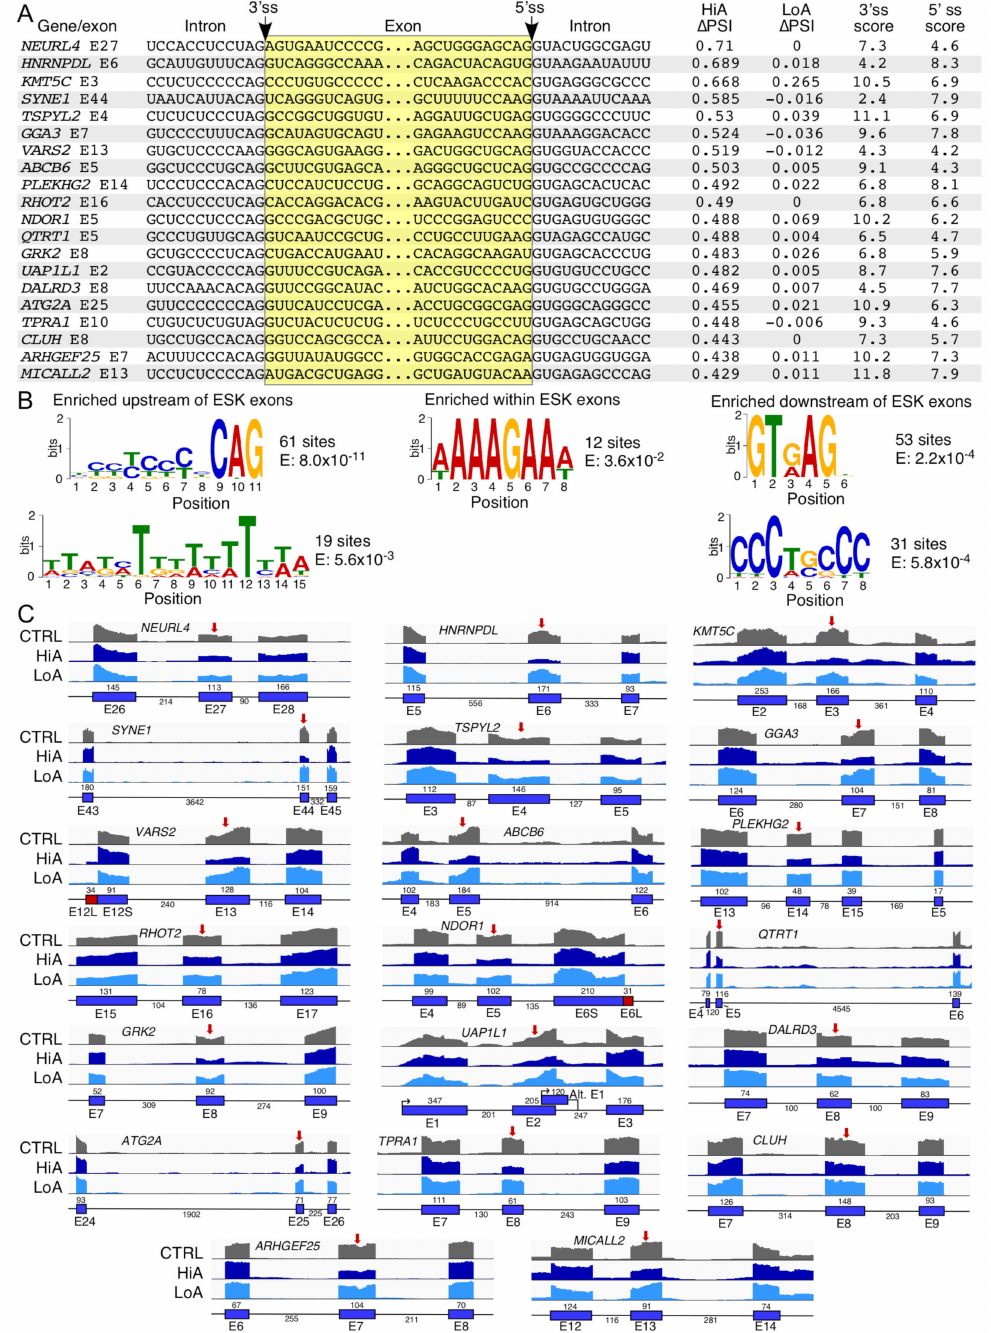
Figure 4. Increased exon skipping caused by Anti-N1 treatment. ( A ). The sequence context of 20 candidate exons exhibiting greatly increased skipping upon Anti-N1 treatment. Table contents and annotation are the same as in Figure 3A. ( B ). Enriched sequence motifs identified by MEME. Left panels: the two most enriched motifs within 50 nucleotides upstream of the 3 (cid:48) ss of affected exons, both corresponding to the polypyrimidine tract and 3 (cid:48) ss sequence. Middle panel: the most enriched motif within the affected exons. Right panels: two motifs enriched downstream of the affected exons. The top motif corresponds to the consensus 5 (cid:48) ss, and the bottom one corresponds to a C-rich motif. n = 100 sequences. ( C ). Genomic views of several candidate exons whose skipping is increased upon Anti-N1 treatment. For each genomic region an exon whose skipping is increased by Anti-N1 treatment is specified with a red arrow. Alternative 5 (cid:48) ss and 3 (cid:48) ss are indicated with red extensions to the original exon. The rest of the labeling and coloring is the same as in Figure